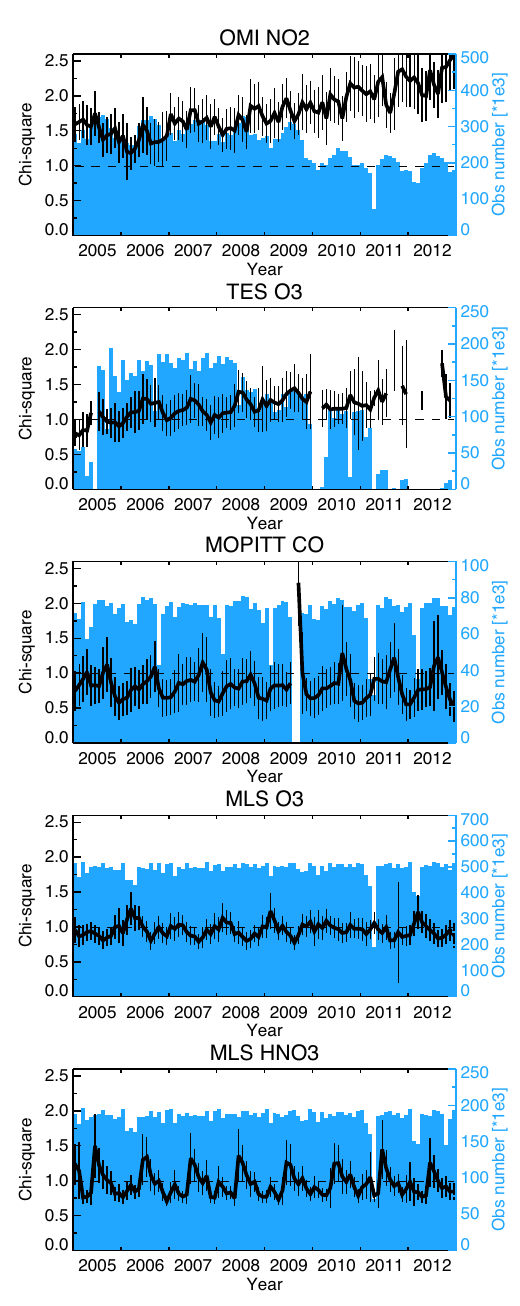
Figure 1. Time series of the monthly mean chi-square value and its standard deviation (black lines) and the number of assimilated ob- servations per month (blue bars) for OMI NO 2 , TES O 3 , MOPITT CO, MLS O 3 , and MLS HNO 3 . A super-observation approach is employed to the OMI and MOPITT measurements (the number of super-observations is shown), whereas individual observations are used in the analysis of the